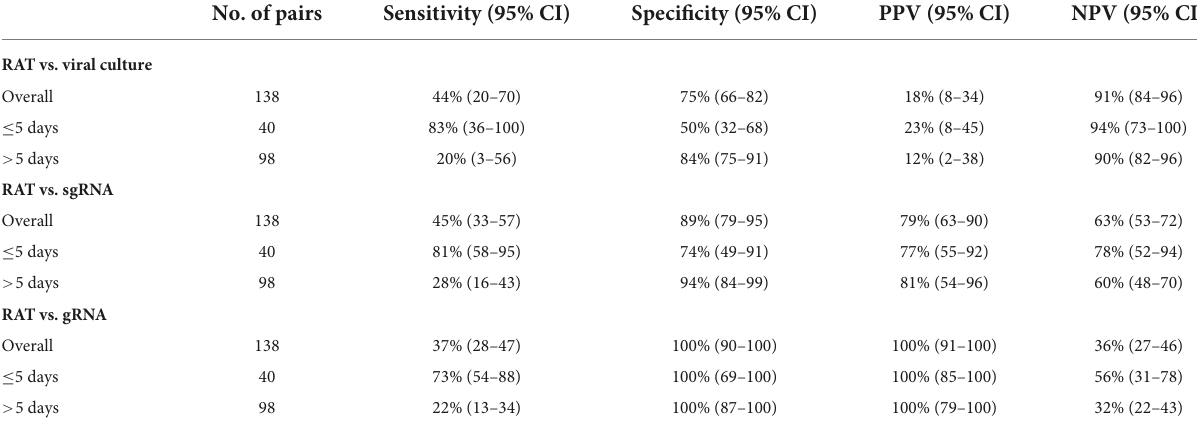
TABLE 2 Performance of self-test rapid antigen tests compared with viral culture, subgenomic RNA, and genomic RNA.